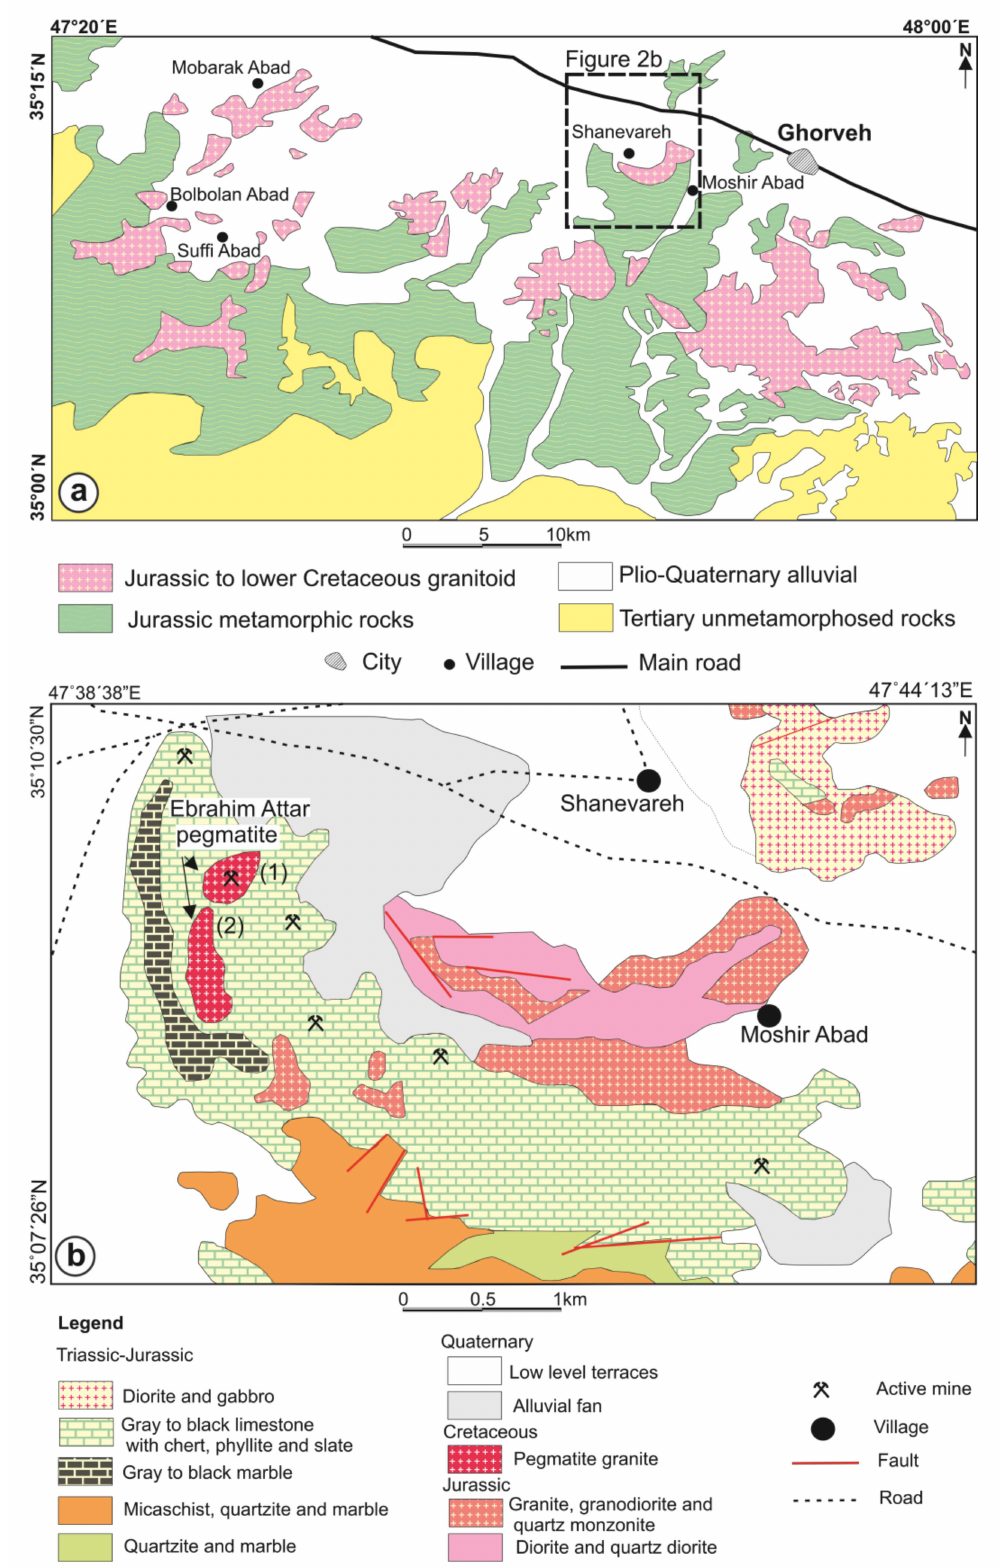
Figure 2. ( a ) Simplified geological map of the Ghorveh area based on 1:100,000 geological maps of Ghorveh, Songhor, and Sanandaj [40–42]. This shows that the Jurassic metamorphic complex is cut by various granites. ( b ) The geological map of the study area indicates that the Ebrahim-Attar granitic pegmatite cuts the Jurassic metamorphic rocks [41]. The Ebrahim-Attar pegmatite has two parts—1 and